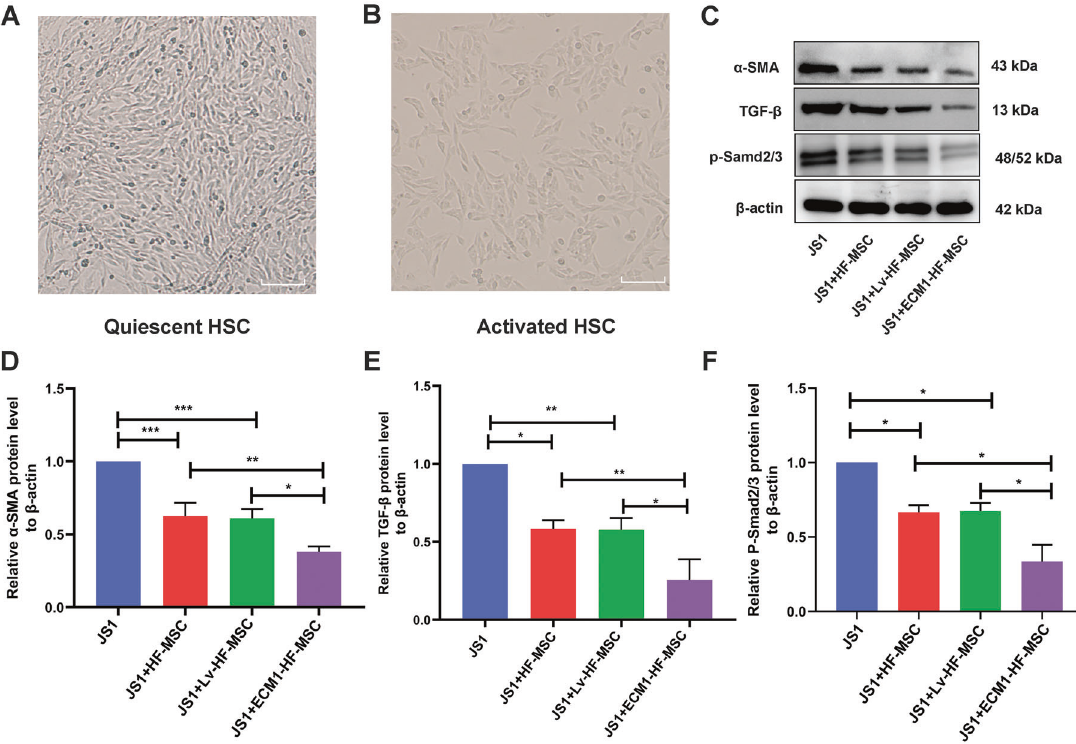
Fig. 5 ECM1-HF-MSCs inhibit the TGF- β /Smad signaling pathway and activation of HSCs in vitro. A The quiescent murine hepatic stellate cell line JS1. B Activated JS1 cells. Scale bar = 50 μ m. C Western blotting analysis of a-SMA, TGF- β , and p-Smad2/3 in all groups. D – F Semiquantitative analysis of the pathway proteins and a-SMA. Data are shown as the means ± SDs (* p < 0.05, ** p < 0.01, *** p <